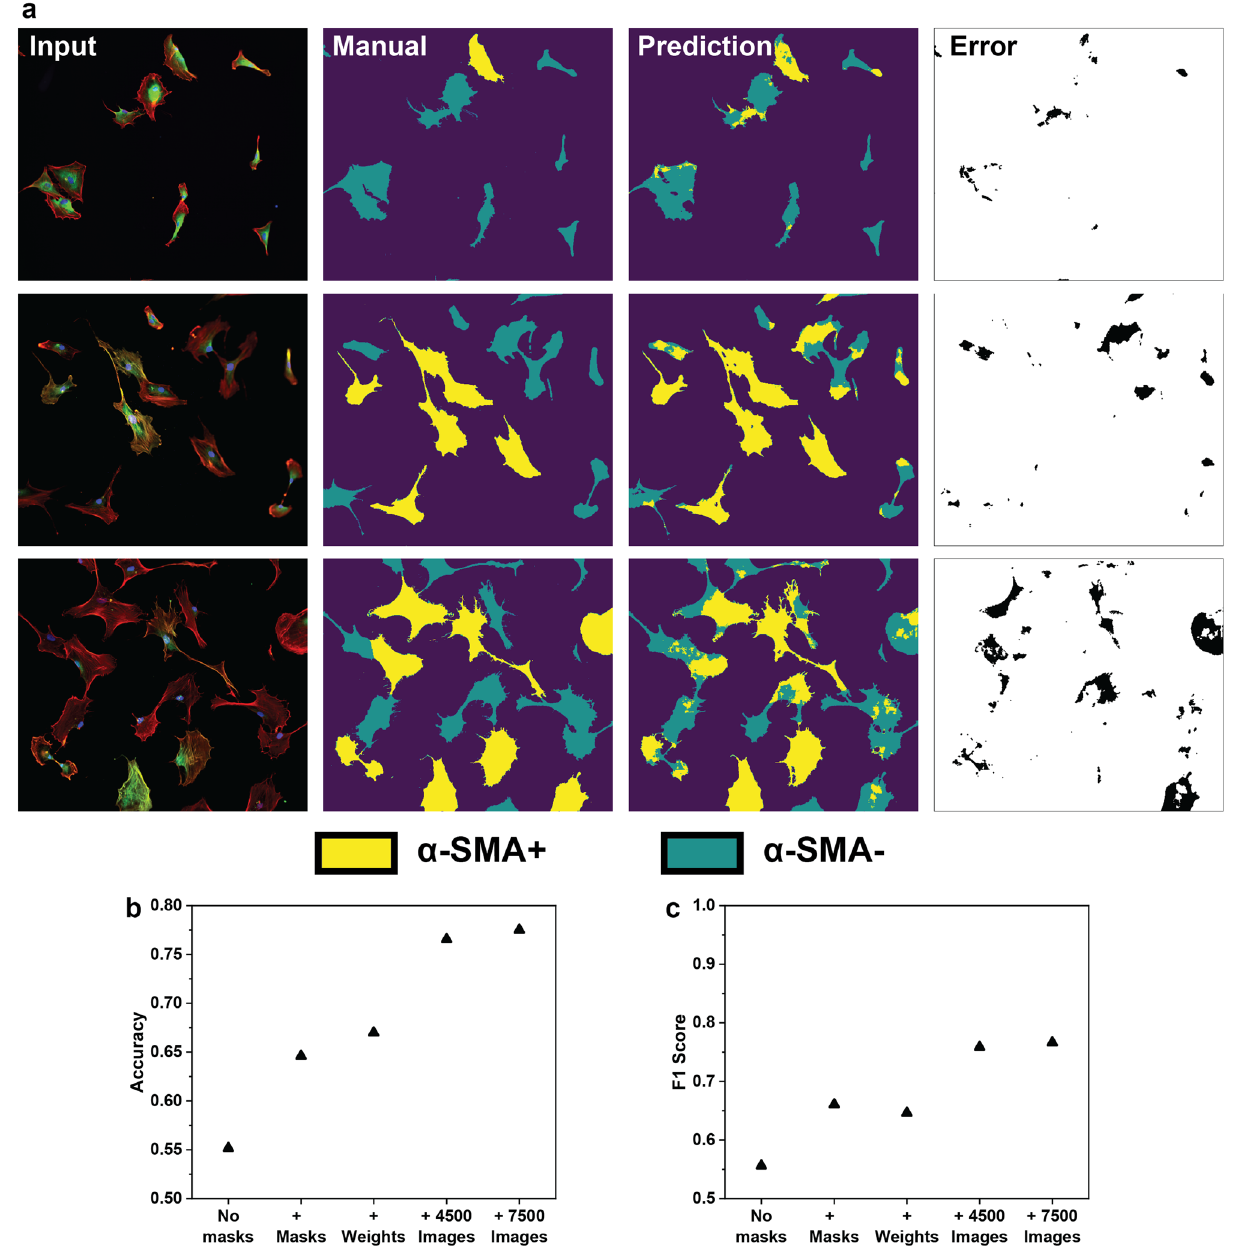
Figure 4. Sample results of 3 images from the test set. ( a ) The first column shows the fluorescent input images, the second column shows cells with organized α-SMA stress fibers as determined by manual identification, the third column shows the model prediction, and the final column highlights areas in the image where the model prediction deviates from the manual identification. ( b ) Model accuracy increased with the addition of class weights and data augmentation. ( c ) The false positive/false negative (FP/FN) ratio was used to measure model bias towards a particular